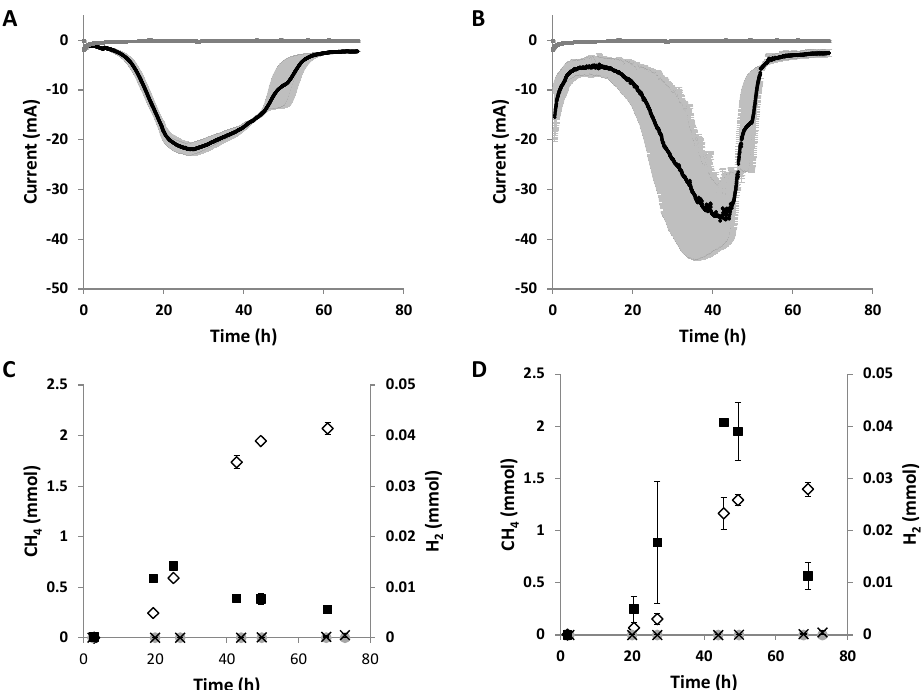
Figure 2. Current consumption during electromethanogenesis with ( A ) M. maripaludis Mic1c10 and ( B ) M. maripaludis KA1. The current consumption of the biological sample (black) and abiotic control (dark grey) is shown. The mean value of two replicates with mean deviation (light grey) is displayed. Methane (white diamonds) and H 2 (black squares) production during electromethanogenesis in ( C ) M. maripaludis Mic1c10 and ( D ) M. maripaludis KA1. Methane and H 2 production in abiotic controls of ( C , D ) are displayed with grey circles and black crosses, respectively. The mean value of two replicates with mean deviation is shown. Table 1. Methane and hydrogen production during MES with different Methanococcus maripaludis strains.